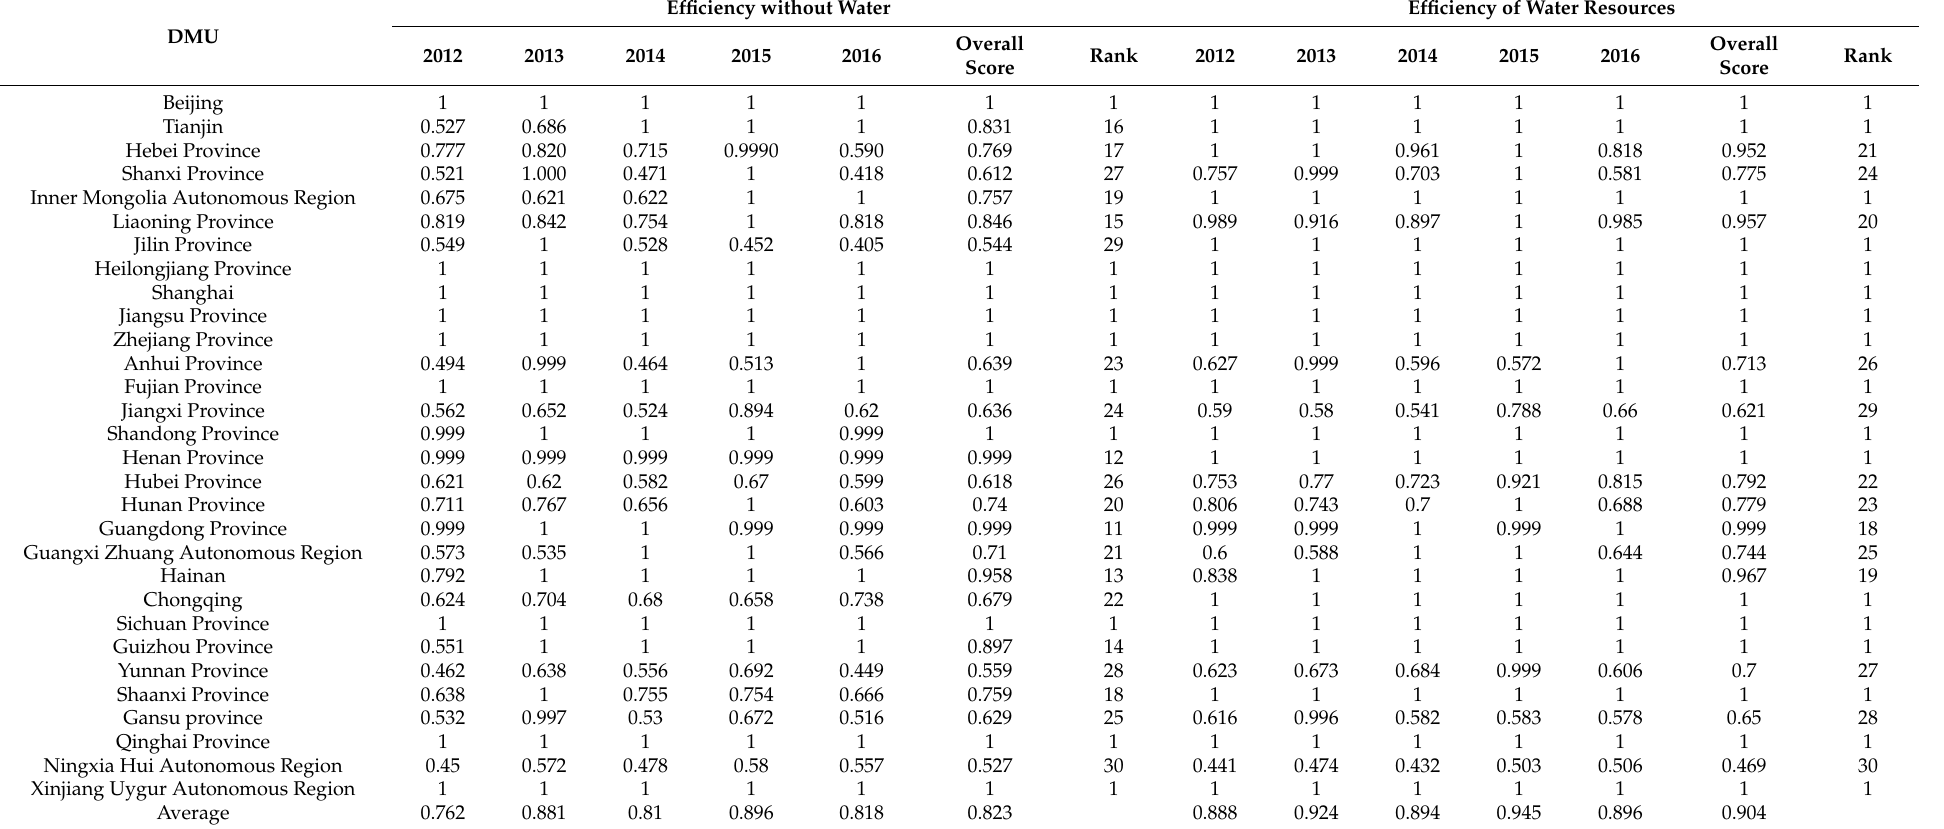
Table 5. Agricultural efficiency performance in China’s 30 administrative